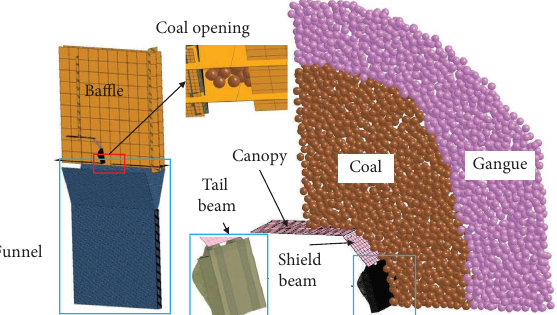
Figure 1: Te numerical model of drawing coal process.